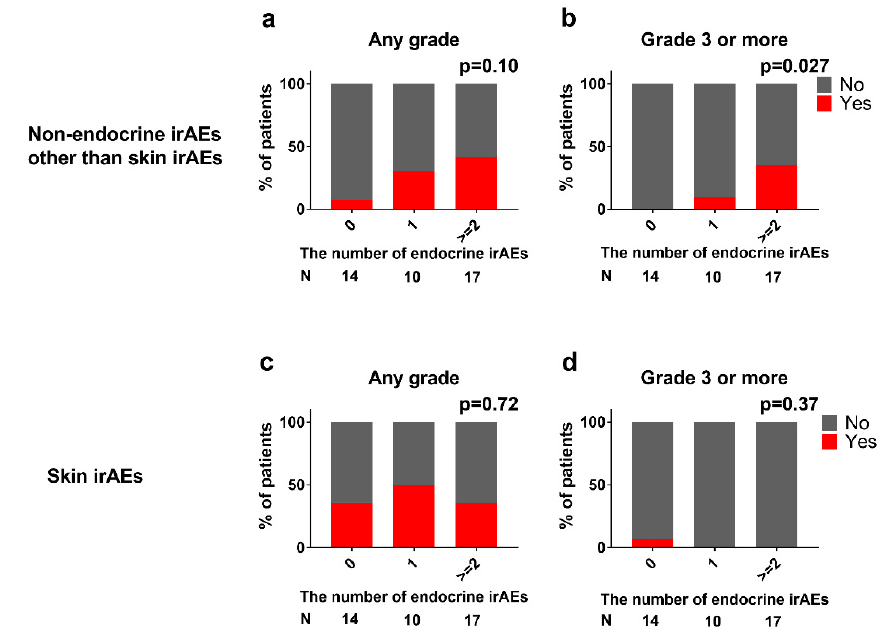
Figure 5. Association of endocrine irAEs with non-endocrine irAEs. The number of endocrine irAEs was associated with non-endocrine irAEs other than skin-related irAEs of any grade ( p = 0.10 ( a )) and Grade 3 or more ( p = 0.027 ( b )) but not with skin-related irAEs of any grade ( p = 0.72 ( c )) nor Grade 3 or more ( p = 0.37 ( d )).